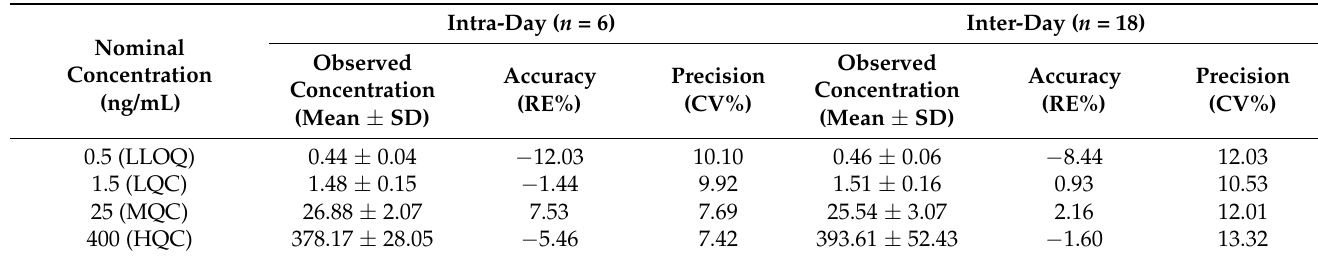
Table 2. Intra-day and inter-day accuracy and precision of MPI8 in rat plasma.